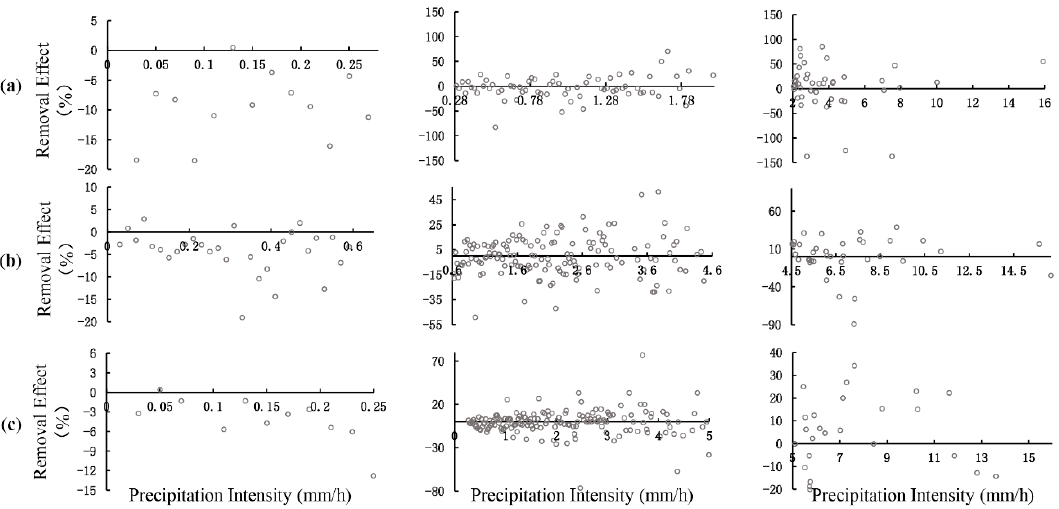
Figure 4. Scatterplot of removal effect versus precipitation intensity for three different ranges of precipitation intensities over ( a ) BTH, ( b ) YRD, and ( c ) PRD regions. Note that the three different ranges of precipitation intensities are classified for negative, neutral, and positive dominant precipitation removal effects, respectively.